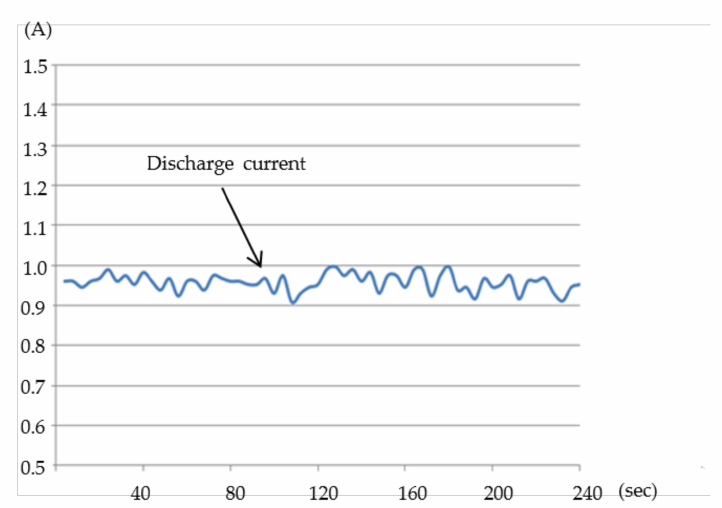
Figure 12. Discharge current value 1 A.